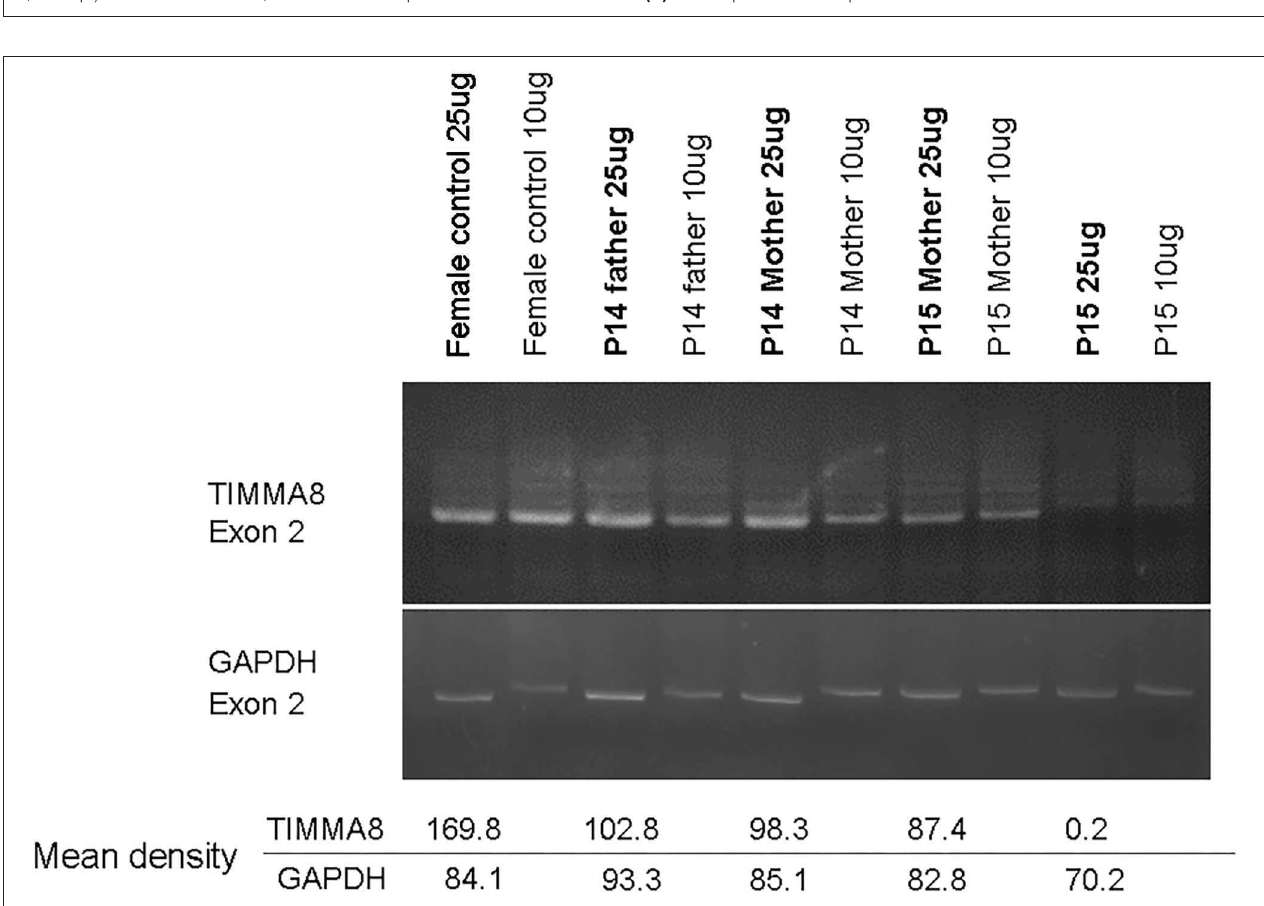
FIGURE 3 | Under the same condition for PCR amplification of candidate genes to predict carrier status, the concentration-density ratio between TIMMA8-exon 2 (total 4 locus in two X chromosome) and GADPH-exon 2 (total 2 locus in one chromosome 12) was 198.8/84.1 in the normal non-carrier female. However, in these two carrier-mothers, the concentration-density between TIMMA8-exon 2 (total 2 locus in one X chromosome) and GADPH-exon 2 (total 2 locus in chromosome 12) was 98.3/85.1 in mother P14 and 87.4/82.8 in mother P15, and both were certainly carriers and equal to a male (P14 father with one X chromosome) 102.8/93.3. This implied the half-dose existence of the TIMMA8 gene on X chromosome in their carrier-mothers compared to the normal healthy females.